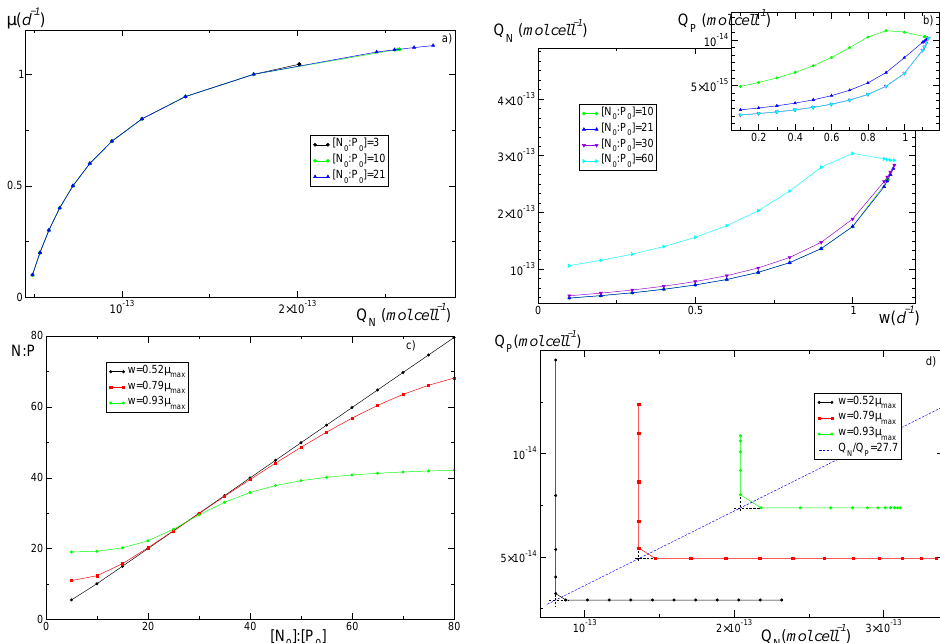
Fig. 2. Curves for growth rate µ , quotas Q , and N : P ratio obtained with a threshold model (Klausmeier et al., 2004b). (a) The growth rate depends only on Q X in the X -limited regime, and the shape of the function (hyperbolic) does not depend on which element is limiting. (b) The use of an identical functional form for the dependence of growth on the limiting quota imposes a symmetry of the Q versus w plots around the optimal input ratio (the symmetry between N and P quotas mentioned in the text). (c) Phytoplankton N : P equals [ N 0 ] : [ P 0 ] only when the growth rate is far from its maximum (small dilution rates). (d) Both nitrogen and phosphorus are essential resources, and as a consequence co-limitation is reached only at one point: the optimal ratio. For the parametrization used here, which corresponds to Scenedesmus sp., this point is [ N 0 ] : [ P 0 ]| opt = 27 .